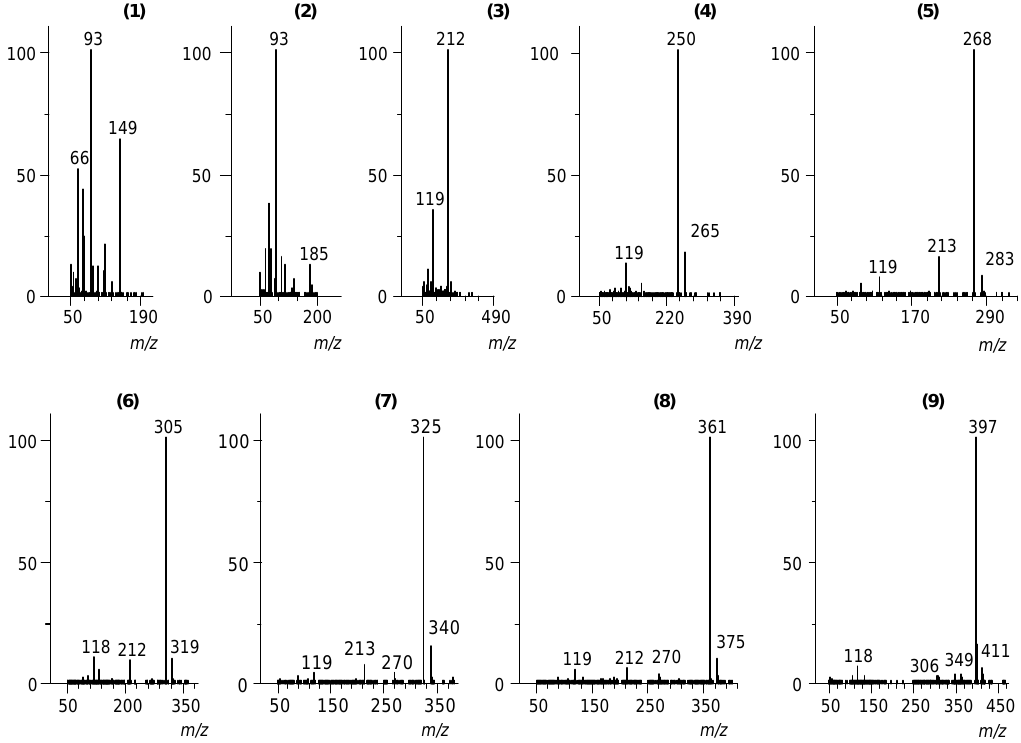
Figure 7. Mass spectra of fractions of organic epoxides synthesized according to methods A (Figure 3) and B (Figure 4). Spectrum numbers (1–9) correspond to the numbers of fractions on chromatograms, Figure 6.